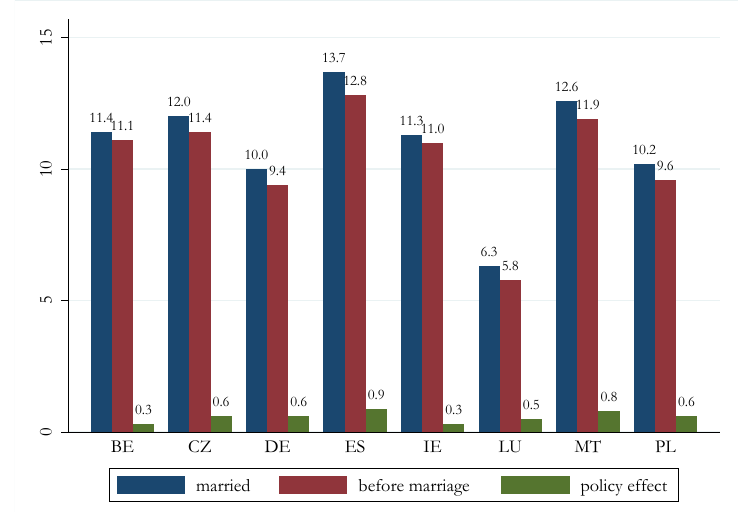
Figure 3. Gender gap in NRR before and after marriage. Notes: EUROMOD estimations for 2019 based on EU-SILC 2019. Before marriage refers to the scenario where married couples are treated as cohabitants by tax-benefit